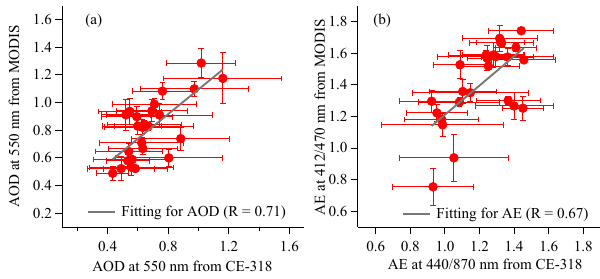
Figure 5. Comparisons between CE-318 and MODIS-based AOD at 550nm and between AE at 440 / 870nm for CE-318 and at 412 / 470nm for MODIS in Nanjing.